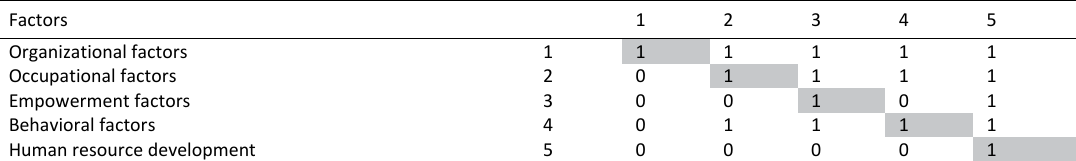
Table 5. Access matrix